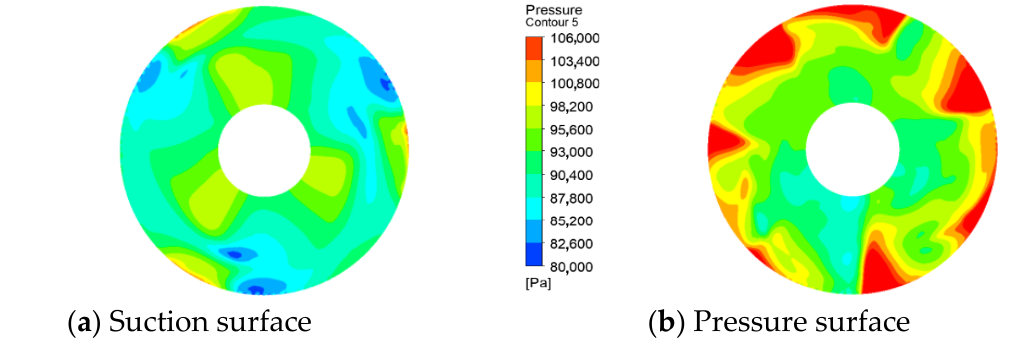
Figure 11. Q = 10 m 3 /s Static pressure distribution of the blade.